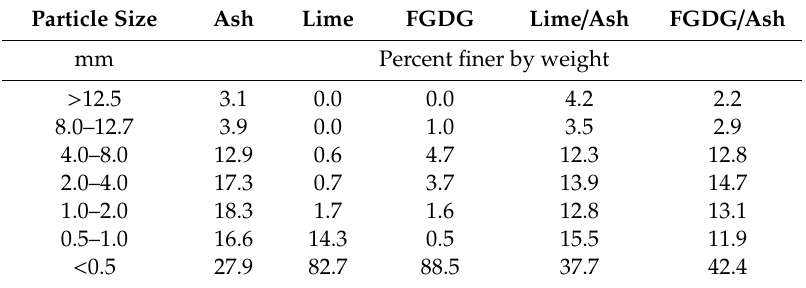
Table 1. Particle size distribution of ash alone, lime, and flue gas desulfurization gypsum (FGDG), and mixtures of 1:4 lime / ash and 1:4 FGDG / ash used in the field spreading uniformity experiment. Data are the mean of four replicate